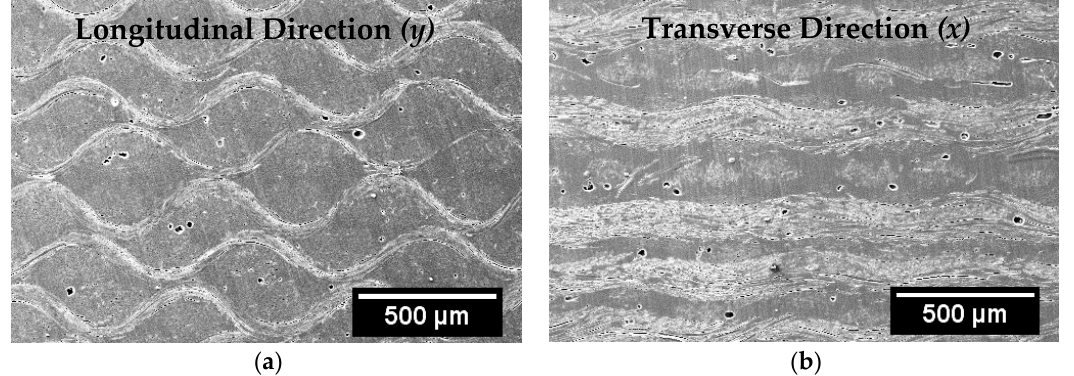
Figure 4. Representative SEM images of the through-the-thickness microstructure of fabricated silk/epoxy composite laminates: ( a ) along the longitudinal ( y ) direction and ( b ) along the transverse ( x ) direction. Both images are at 30×.